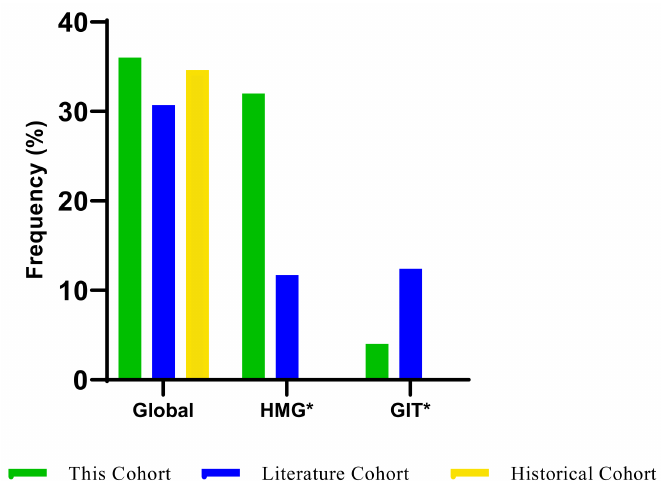
Figure 5. Plot of global and overall adverse events markers in 3 cohorts. Global includes all fluoropyrimidine-related AEs grade ≥ 3. It might not include dose reduction and treatment discontin- uation. GIT* Gastrointestinal markers include nausea, vomiting, and diarrhoea. HIG* Haematological markers include neutropenia, leukopenia, thrombocytopenia, and anaemia.